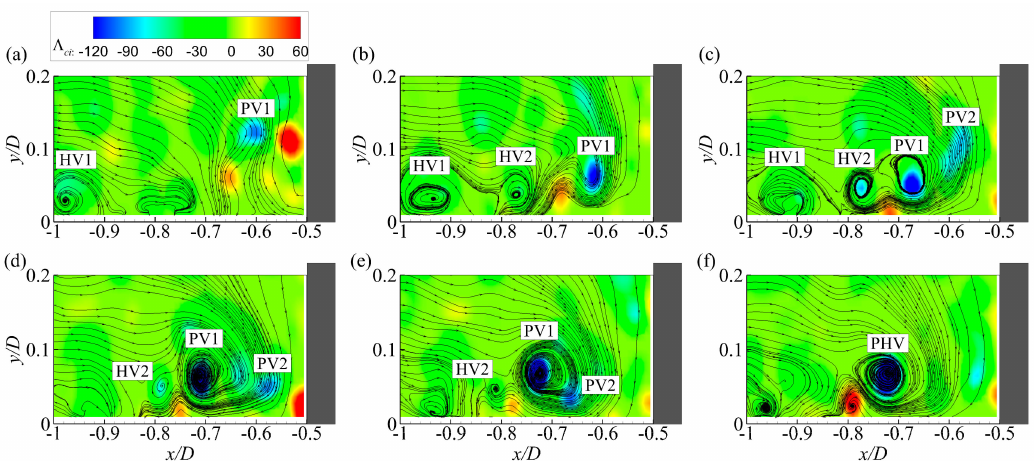
Figure 6. Sequence of instantaneous velocity fields illustrating the generation of a PHV for case C13900. ( a ) t = 0; ( b ) t = 0.40 D / U m ; ( c ) t = 0.60 D / U m ; ( d ) t = 0.81 D / U m ; ( e ) t = 1.01 D / U m ; ( f ) t = 1.22 D / U m.